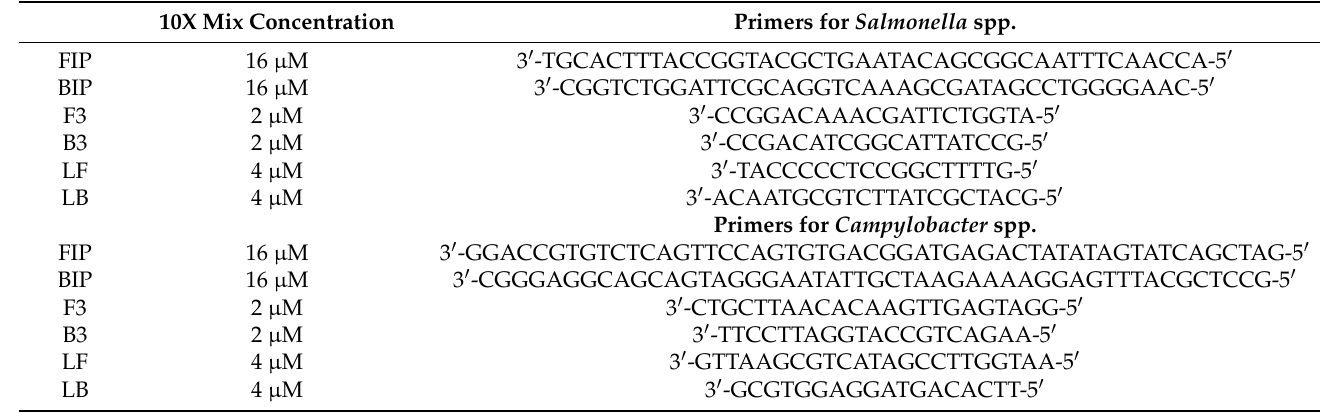
Table 2. List of LAMP primers used for the amplification of Salmonella enterica and Campylobacter spp., and the composition of the 10X primer mix used in the LAMP assays